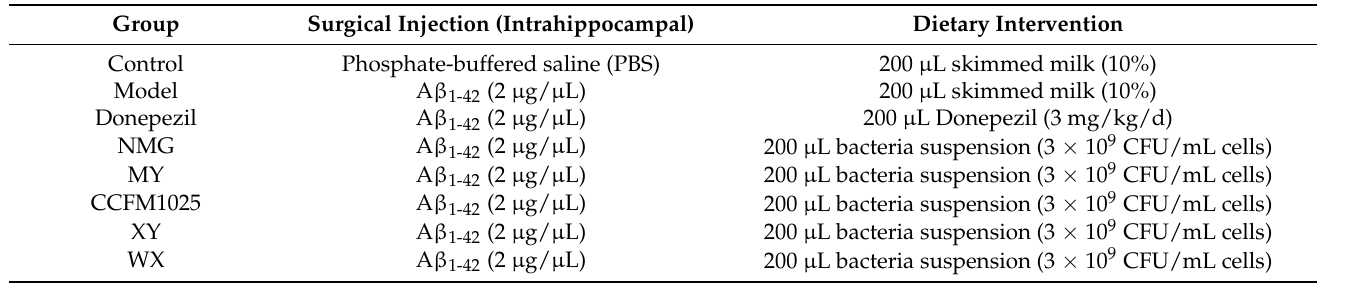
Table 2. The treatment of mice in different groups.